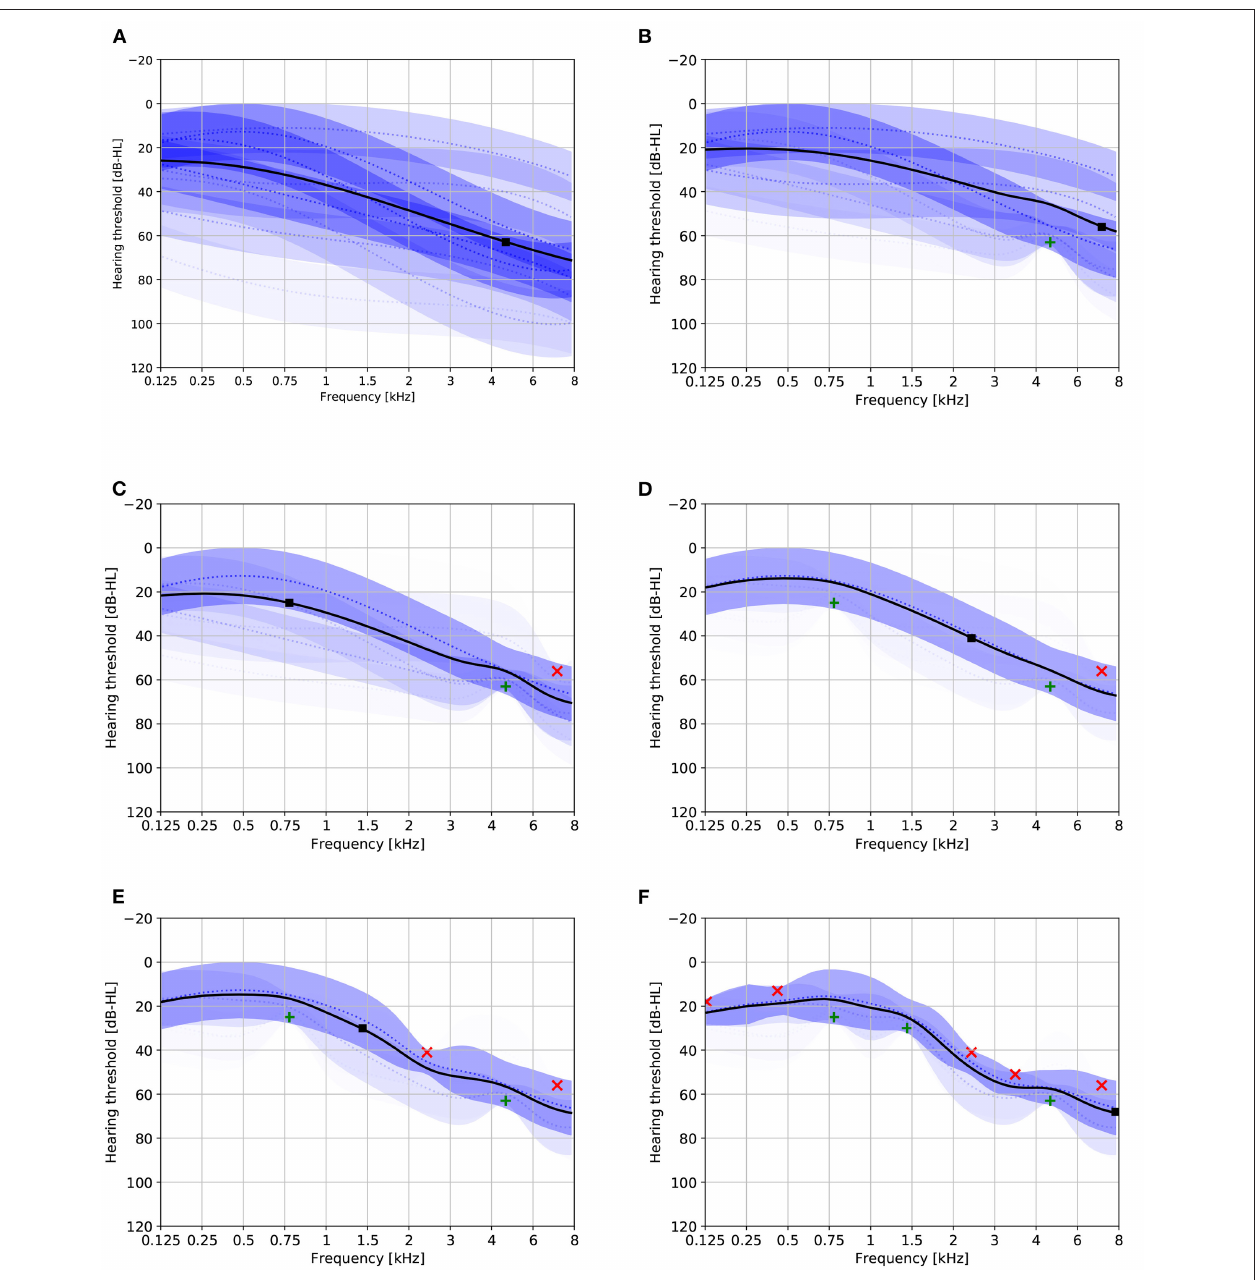
FIGURE 5 | Audiogram plots visualizing the progression of a single Bayesian PTA simulation under the eight-component model. Solid black lines denote the HT estimate. Dotted blue lines and shaded areas depict the individual GP mixture components ± 1 standard deviation (the transparency is proportional to the mixing weight). Green and red crosses, respectively, depict audible and non-audible responses. Solid black boxes indicate the optimal next stimulus. (A) Audiogram based on zero responses. (B) Audiogram based on one response. (C) Audiogram based on two responses. (D) Audiogram based on three responses. (E) Audiogram based on four responses. (F) Audiogram based on eight